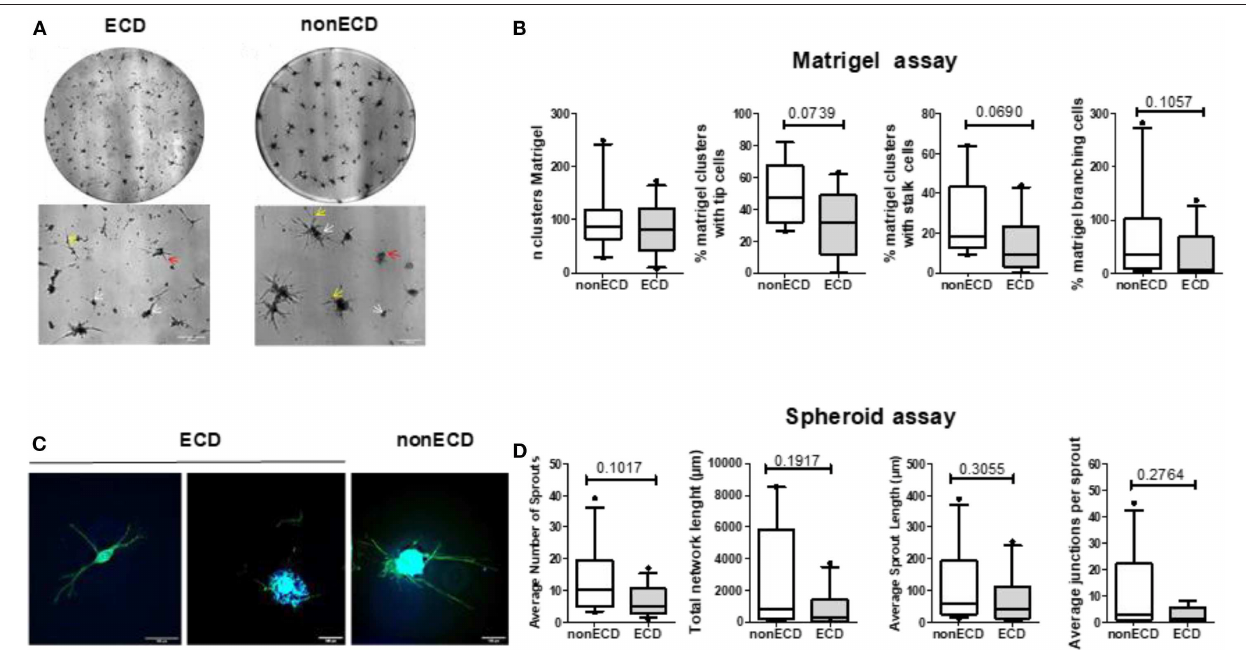
FIGURE 2 | (A) Representative experiment of capillary tube formation by SVF from ECD or non-ECD. A total of 20,000 cells/well were seeded on growth factor reduced Matrigel. Images were recorded at 72h with a phase-contrast microscope. Original magnification x5; upper panel (scale bars, 300 µ m) correspond to the total image of the well while the lower panels were zooms of previous images (scale bars, 200 µ m). White arrows identify initial cell clustering; red arrows marked the tip cells while yellow arrows identified branching. (B) Quantitative analysis of number of clusters, percentage of clusters with tip and stalk cells, number of branching points. Data are expressed as means ± SEM of independent experiments performed in triplicate using PRAT-SVF obtained in 14 ECD and 10 non-ECD donors (C) Representative experiment of 3D in vitro angiogenic assay with collagen gel-embedded spheroids of SVF from ECD or non-ECD (original magnification x20; scale bars, 100 µ m). Imaging of Vascular sprouts was obtained after merging of actin staining (phalloidin in green) and nuclei staining (DAPI, blue) as detailed in Supplementary Figure 2 (D) Quantitative analysis of number of sprouts, branch points, and total network length per spheroid as well as average sprout length was compared in PRAT-SVF from the ECD and non ECD donors. For each experiment, at least 10 spheroids were